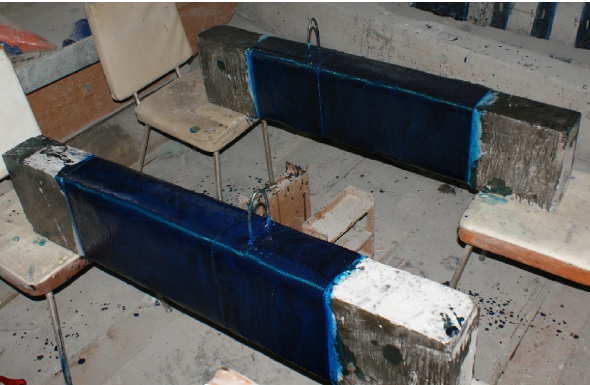
Figure 6. General view of the column, reinforced according to the X5 variant—a full clip of three layers of carbon fiber MBRACE FIB CF 300/4900.300 g/5.100 m.